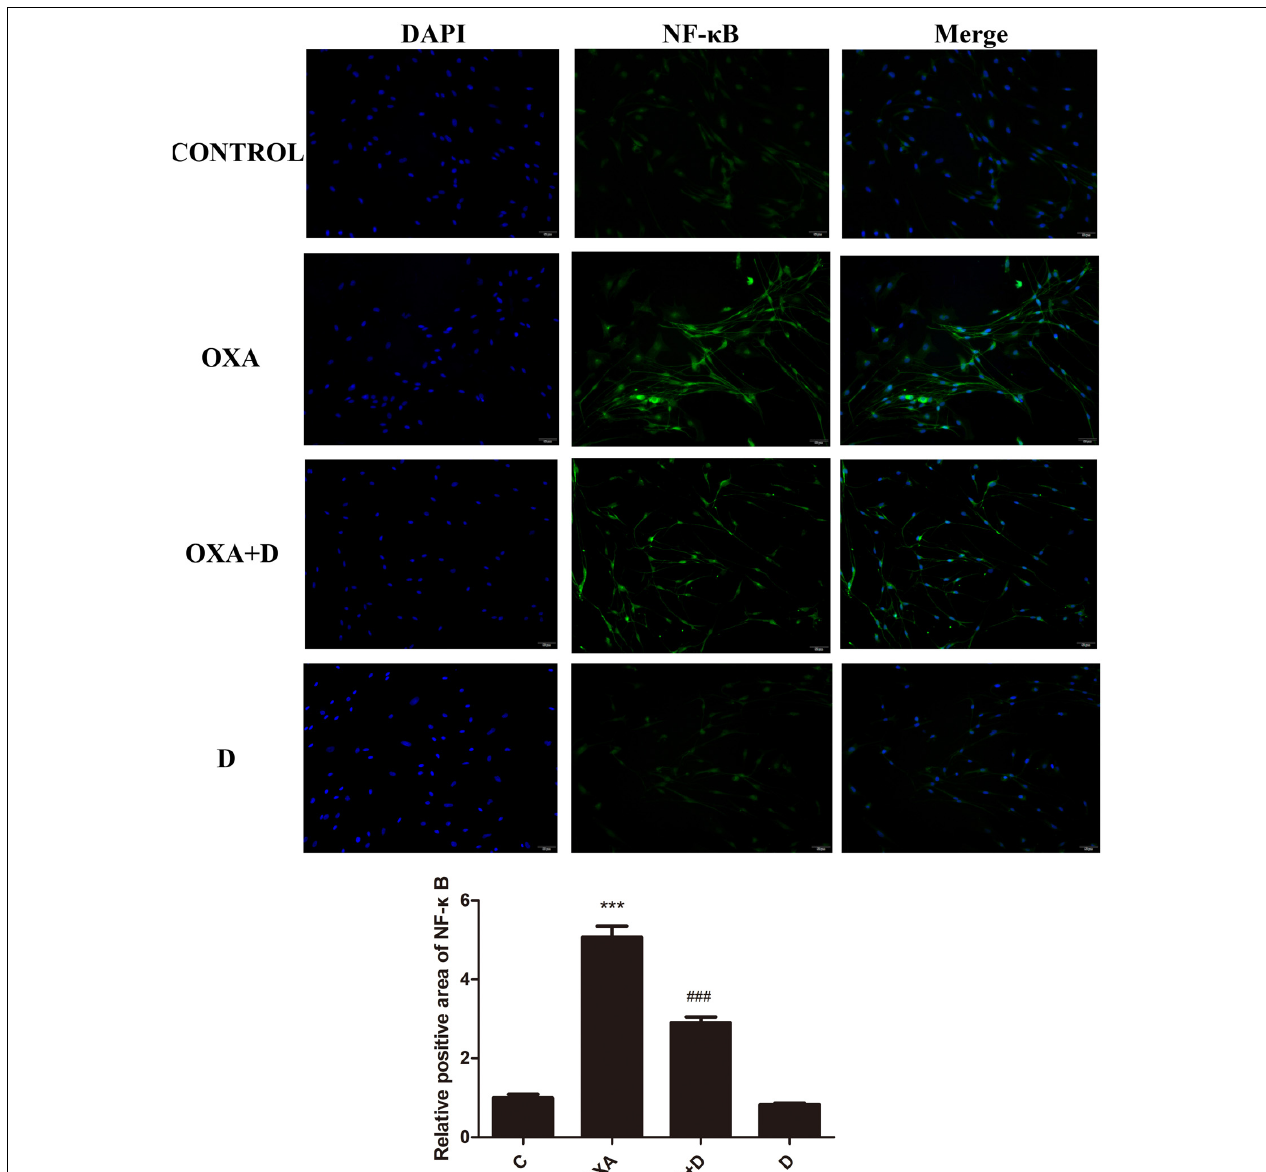
FIGURE 8 | Effect of oxaliplatin and duloxetine on the expression of nuclear NF- κ B in DRG neuronal cells. DRG neuronal cells were treated with (or without) OXA (3 µ M) and duloxetine (3 µ M) for 48 h and were double-stained with DAPI and NF- κ B. The fluorescence intensity was observed using fluorescence microscopy ( × 200). ( ∗∗∗ p < 0.001 vs. control; ### p < 0.001 vs. OXA).